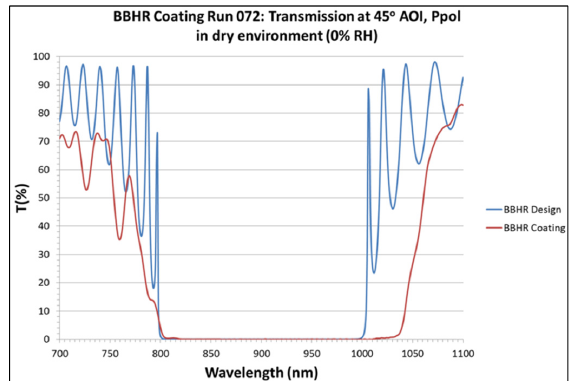
Figure 12. Transmission spectrum as measured under dry (0% RH) conditions at 45° AOI, Ppol for the BBHR coating of Run 072, with the measured spectrum shown compared to the coating’s design transmission spectrum. This figure appears as Figure 2 of our earlier report [15].